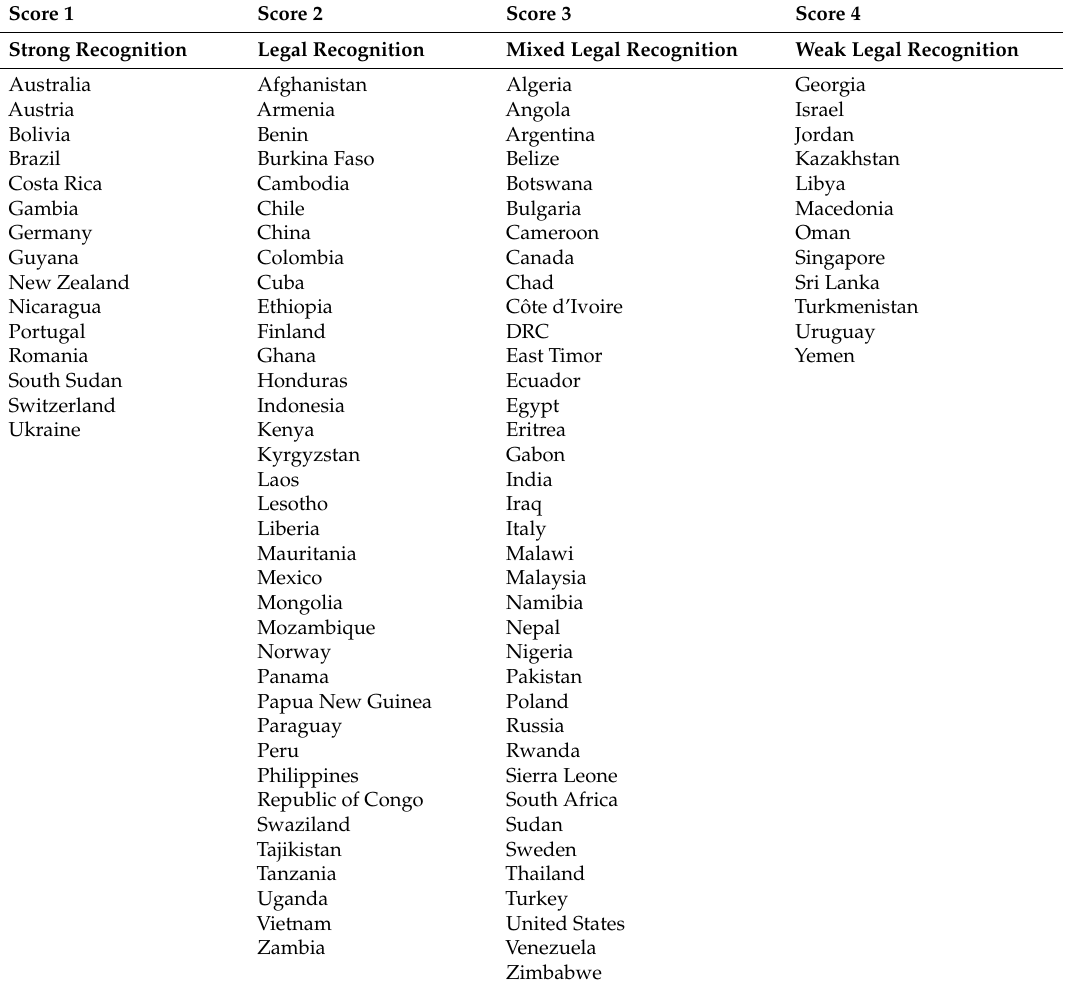
Table 1. Legal recognition of community water rights among the